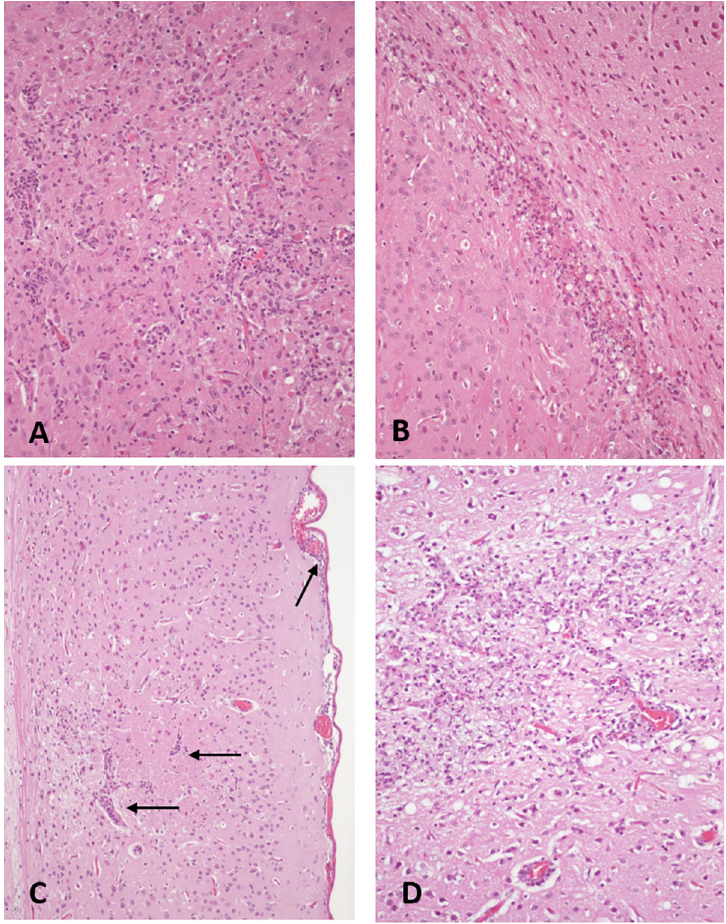
T-AT /WNV-prME. A. Brain section from mouse culled at day 3 p.i. showing widespread infiltration of neutrophils and monocytes in the neuropil accompanied by gliosis (overall marked increase in cellularity). B. Brain section from mouse culled at day 5 p.i. showing extension of inflammation into other parts of the brain distant from the injection site. C. Brain section from animal culled on day 22 p.i. where evidence of severe meningo-encephalitis is still present with perivascular cuffing and leukocyte infiltrates in the meninges (arrows). D. Brain section from mouse culled on day 22 p.i. and demonstrating persistent severe inflammation throughout the neuropil. Hematoxylin and eosin